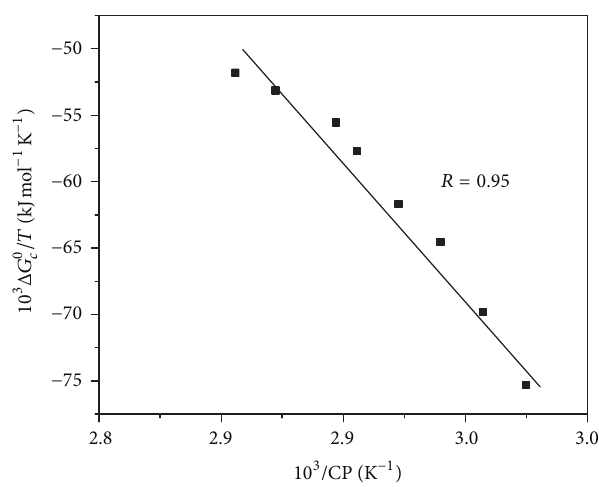
Figure 4: Δ𝐺 0 𝑐 /𝑇 versus 1/𝑇 plot of the NORT-HPMC system in presence of 10mMNaCl (type 1).